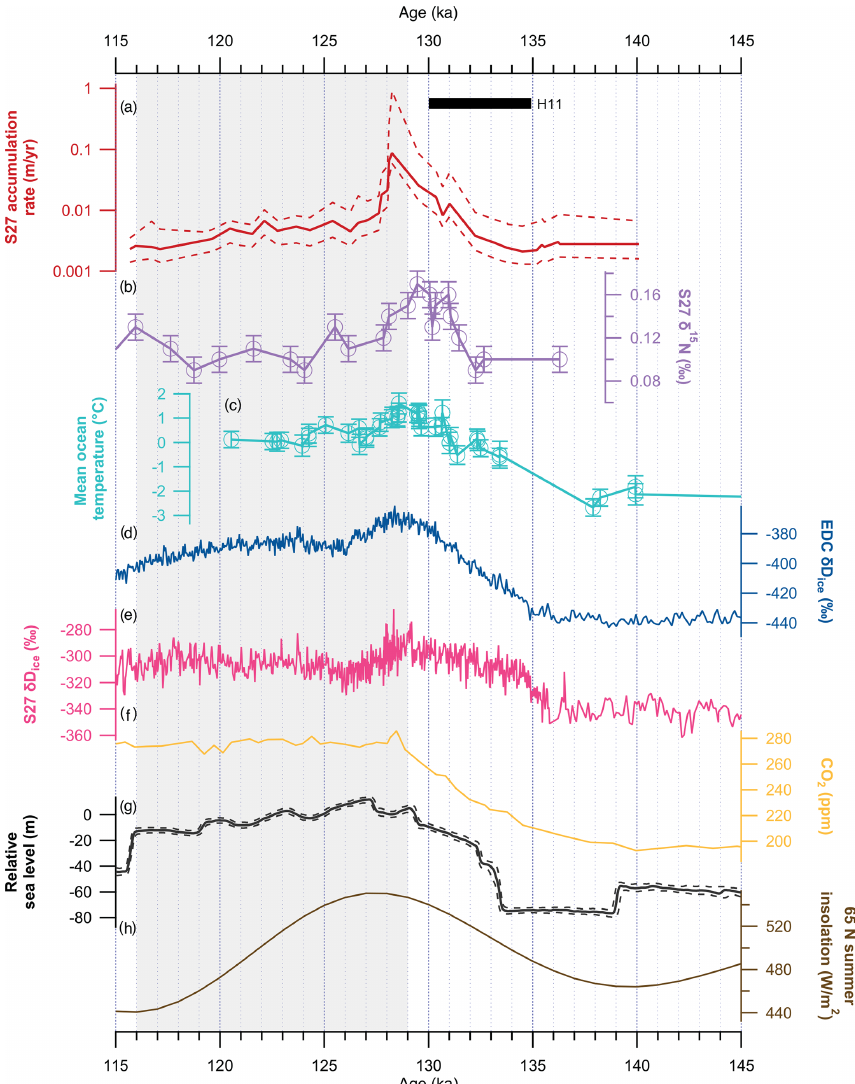
Figure 9. Paleoclimate records during Termination II and the Last Interglacial. (a) S27 accumulation rate (this study) deduced from ice without any visible fractures. (b) δ 15 N of N 2 in S27 (this study). (c) Mean ocean temperature based on noble gas ratios (Shackleton et al., 2020). (d) S27 stable water isotope records (Spaulding et al., 2013). (e) EPICA Dome C δ D ice records (Jouzel et al., 2007). (f) Atmospheric CO 2 (Bereiter et al., 2015, and references therein). (g) Sea level relative to the present day inferred from δ 18 O of Red Sea planktonic foraminifera with 95% confidence interval marked by the dashed lines (Rohling et al., 2019). (h) The 21 July insolation at 65 ◦ N. Shaded zone marks the LIG. The black bar marks Heinrich event 11